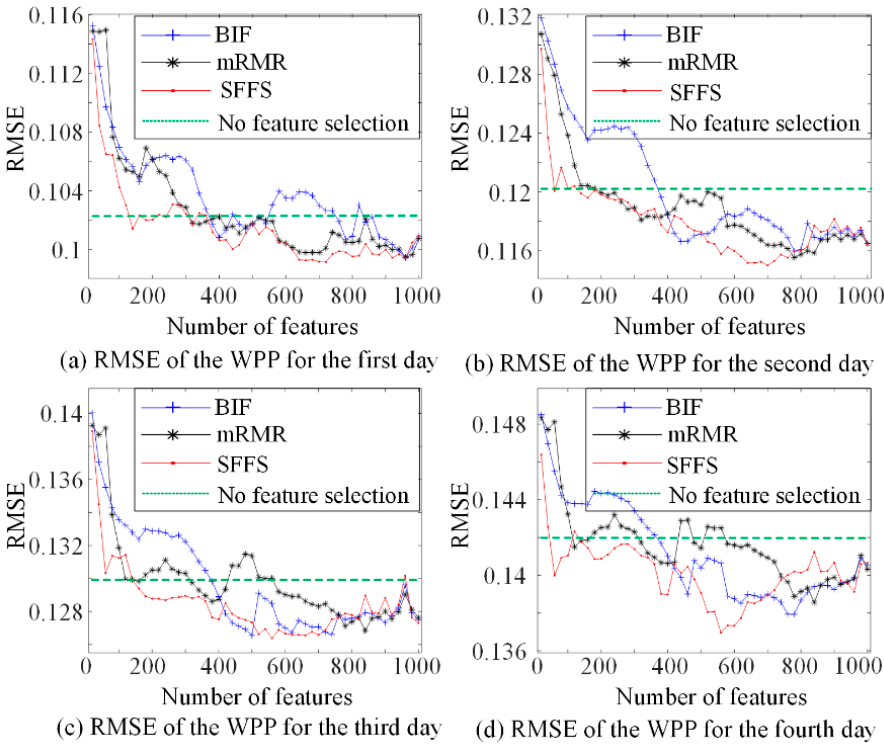
Figure 10. Comparison of three feature selection methods by daily statistics. Statistical analysis is carried out for the top 660 features selected by the SFFS method. Some aspects of the features, in terms of their frequency level and the wind farm that they belong to, are enumerated in Table 5. Table 5. First 660 features selected by the SFFS method.